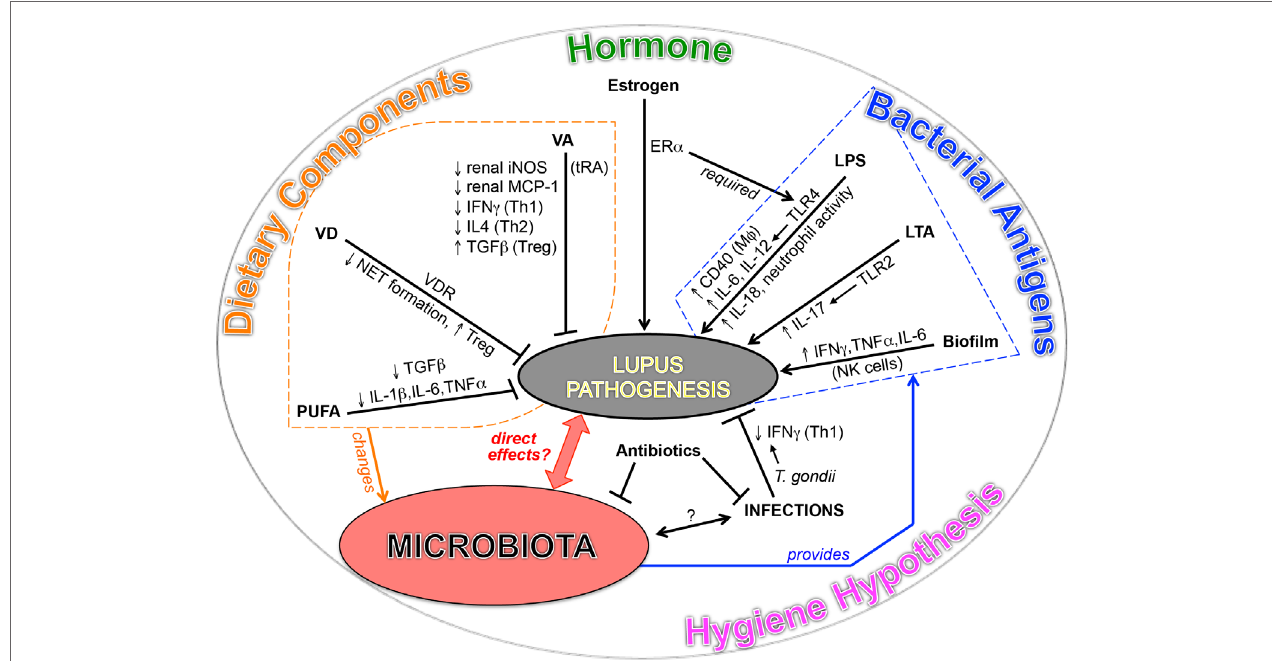
FiGURe 1 | emerging evidences point to a potential link between SLe and microbiota